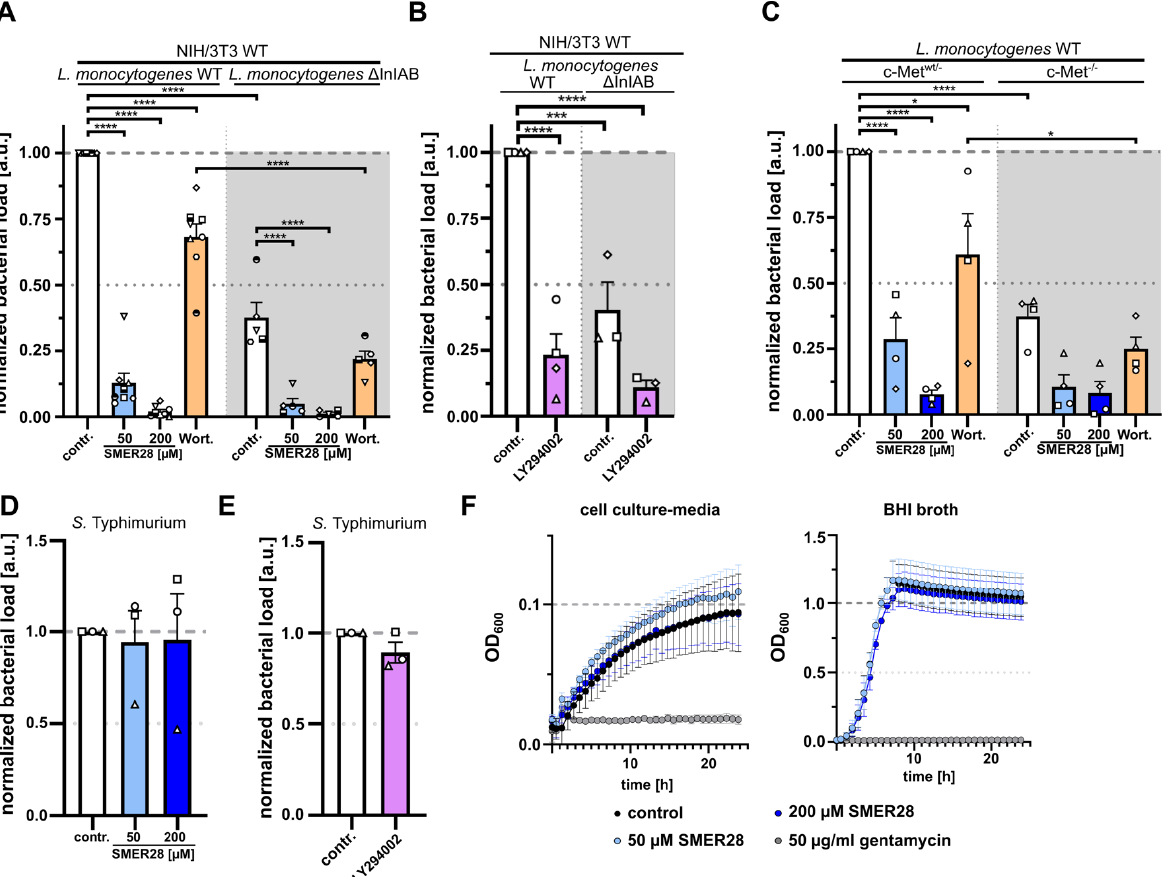
Figure 6. SMER28 efficiently inhibits Listeria uptake. ( A ) NIH/3T3 cells pre-treated with or without 50 or 200 µ M SMER28 or 50 nM wortmannin for 16 h were explored by gentamycin protection assay for invasion of L. monocytogenes wild-type and ∆ InIA/B mutant. ( B ) NIH/3T3 cells were pre-treated with or without 50 µ M LY294002 for 30 min and subjected to gentamycin protection assay using L. monocytogenes wild-type and ∆ InIA/B. ( C ) c-Met WT/ − and c-Met − / − cells were pre-treated as described in A and examined by gentamycin protection assay with L. monocytogenes wild-type as above. ( D ) NIH/3T3 cells were pre-treated with or without 50 or 200 µ M SMER28 for 16 h. Cells were then subjected to gentamycin protection assay with S. Typhimurium as invasive pathogen. ( E ) NIH/3T3 cells were pre-treated with or without 50 µ M LY294002 for 30 min and examined by gentamycin protection assay for invasion of S. Typhimurium. In ( A – E ), all bars display means from at least three independent experiments ± s.e.m. ( F ) Planctonic growth assay of L. monocytogenes wild-type bacteria in cell culture media (left graph) and in BHI broth (right graph). Media were supplemented with or without 50 µ M SMER28, 200 µ M SMER28 or 50 µ g/mL gentamycin, as indicated. OD600 was measured every 15 min for 24 h. Graphs display means from three independent experiments ± s.e.m. * p < 0.05, *** p < 0.001, **** p < 0.0001; one way